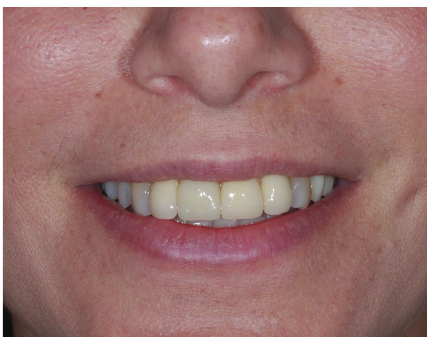
Figure 29: Frontal view showing the aesthetic result at the five-year follow-up examination.